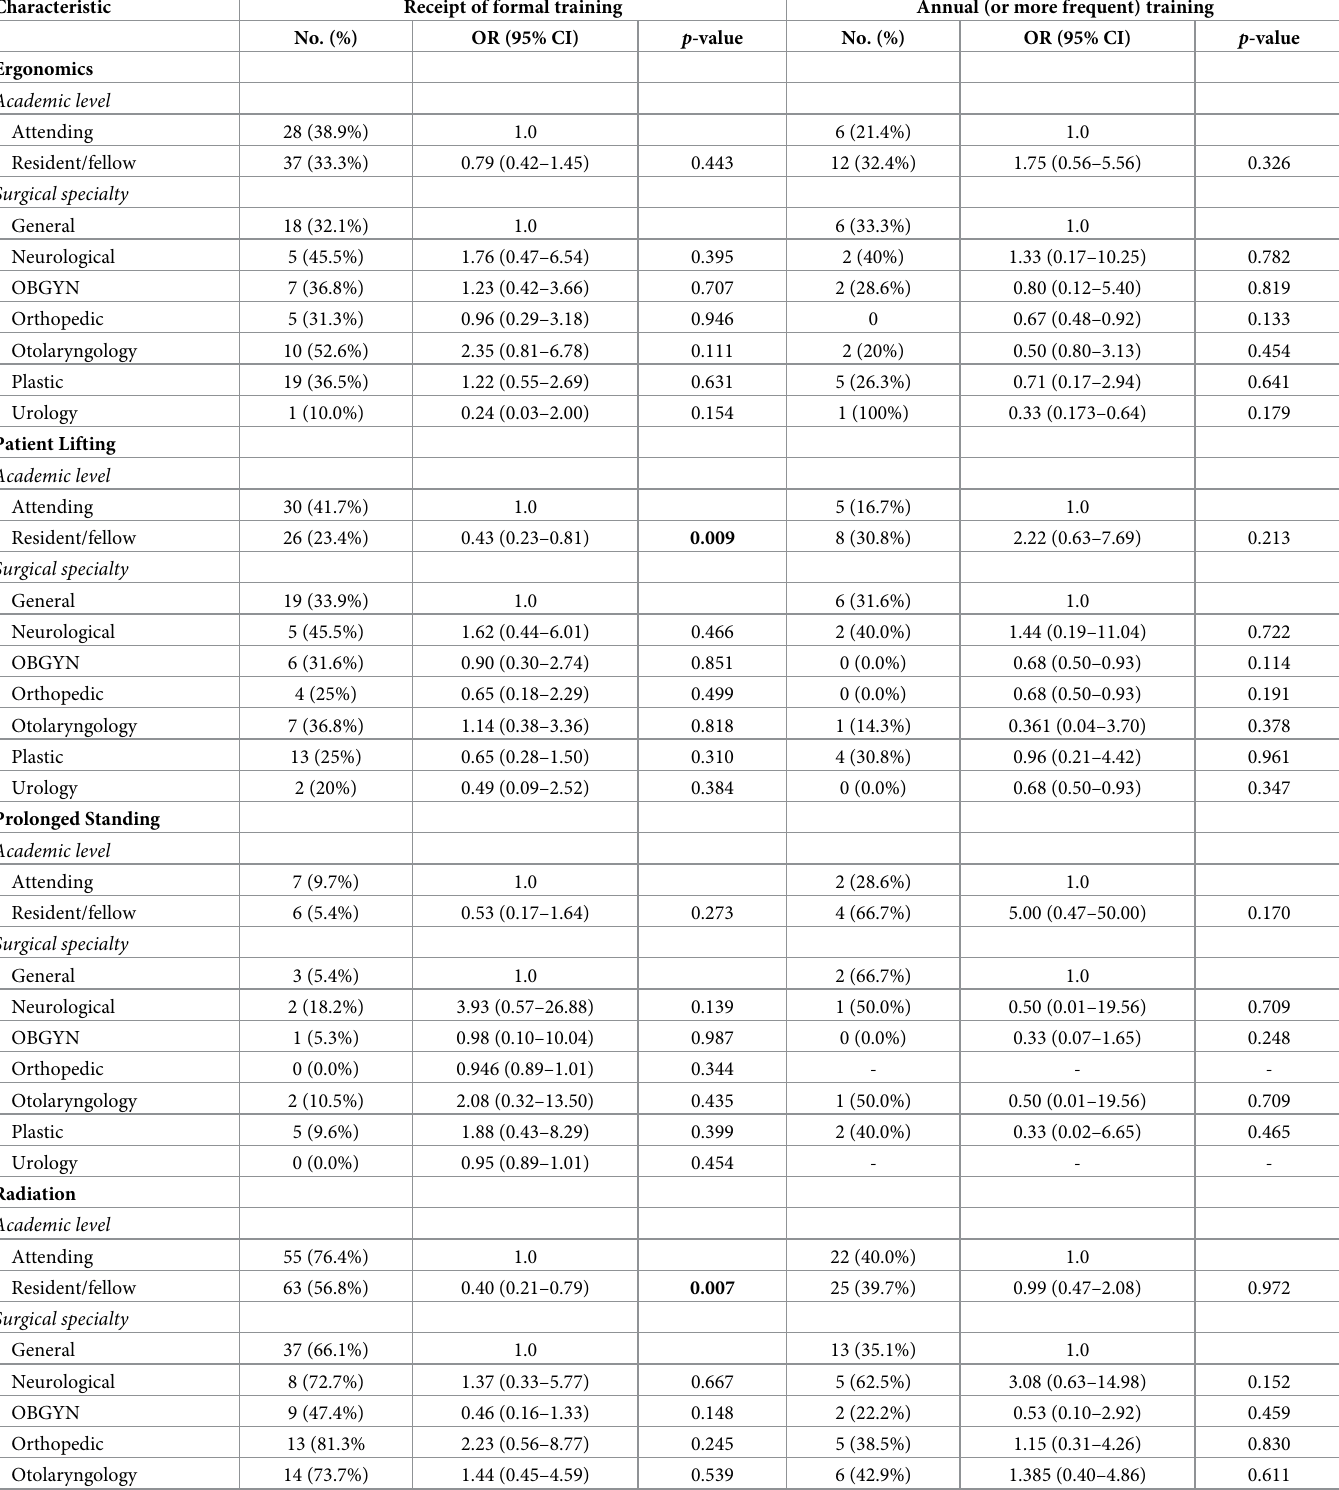
Table 3. Receipt and frequency of formal training for physical occupational hazards stratified by academic level and surgical